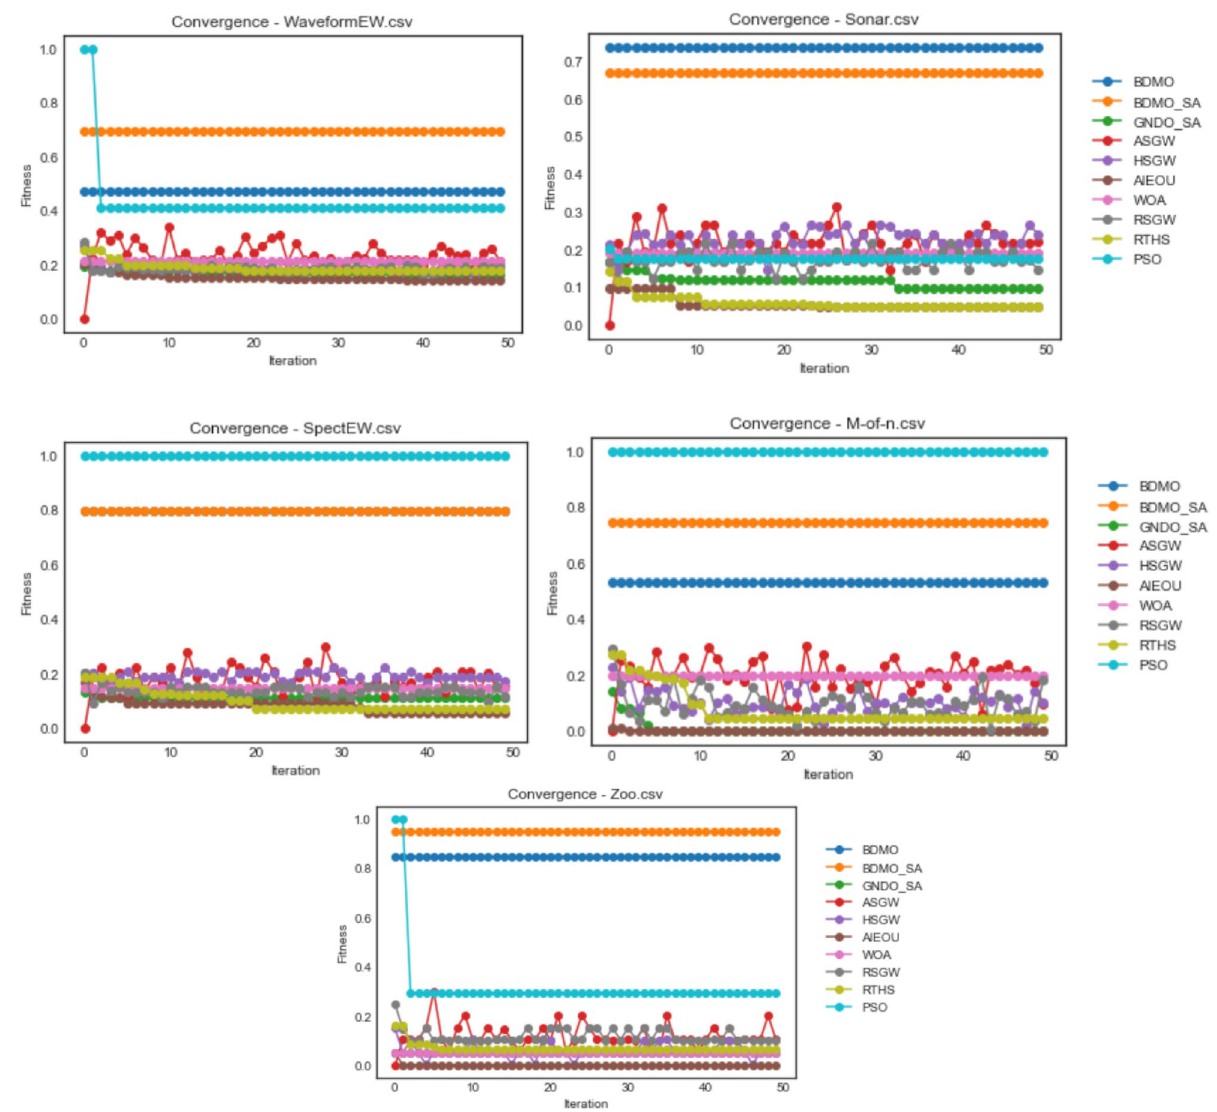
Figure 4. Convergence behavior of all algorithms on waveformEW, sonar, SpaceEW, M-of-n, and Zoo